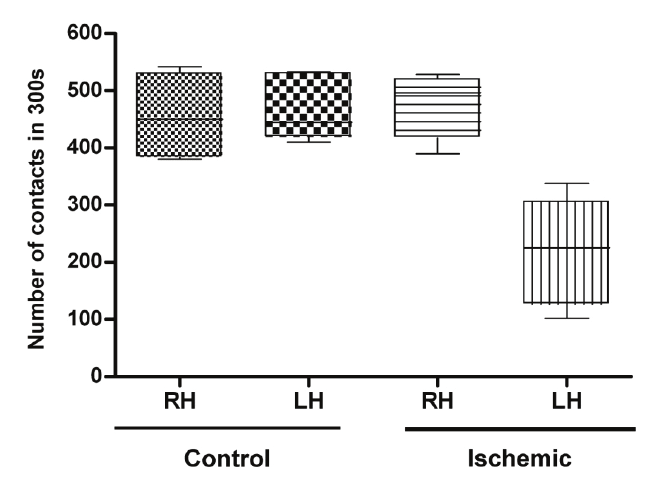
FIGURE 3 - Number of contacts in 300 s of righ hinbdlimb (RH) and left hindlimb (LH) of rats of Ischemic and Control groups. (—) mean; (□) confidence interval; (‡) standard deviation.